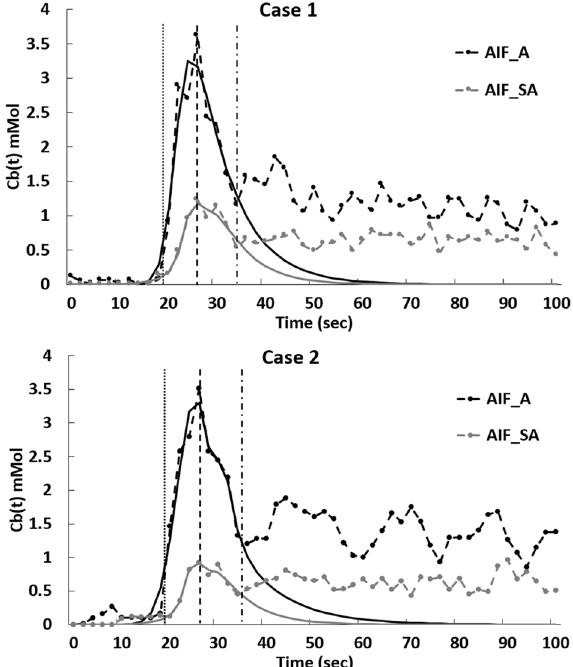
Figure 5. Concentration time curves and the corresponding first-pass fitted curves of the aorta and segmental artery of two participants. Dotted vertical lines represent the arrival of the first pass, dashed lines represent the peak, and dash-dotted lines represent the arrival of second pass of contrast-agent-containing blood. Black dashed curves represent the fit curves for the aortic arterial input function (AIF). Gray dashed curves represent the fit curves for the segmental arterial